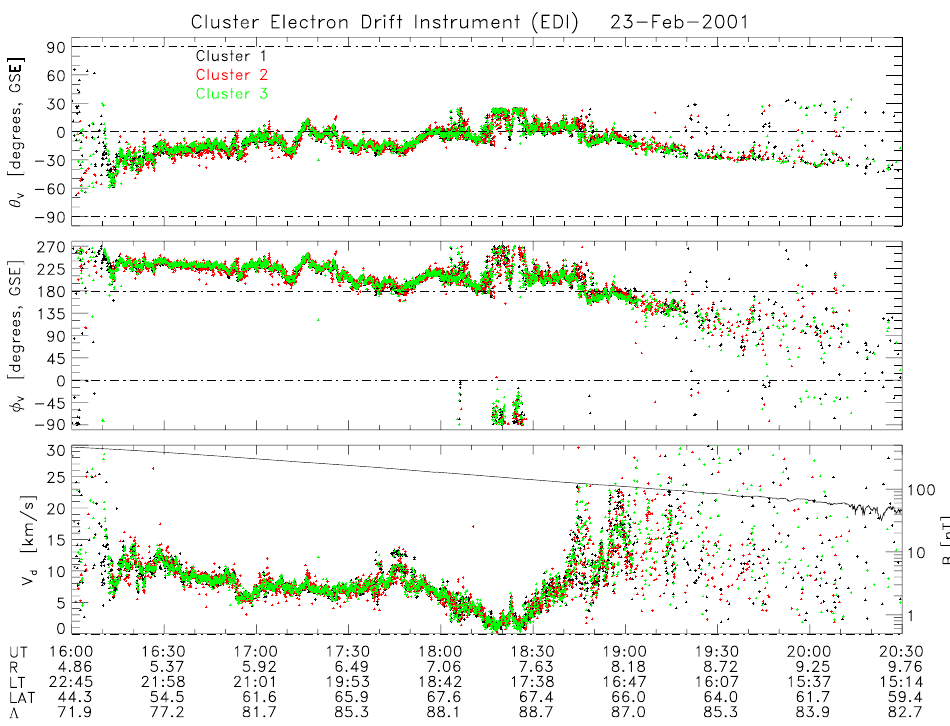
Fig. 10. Outbound pass on 23 February 2001, in the same format as Fig. 7, i.e. with the spacecraft velocity corrected for.